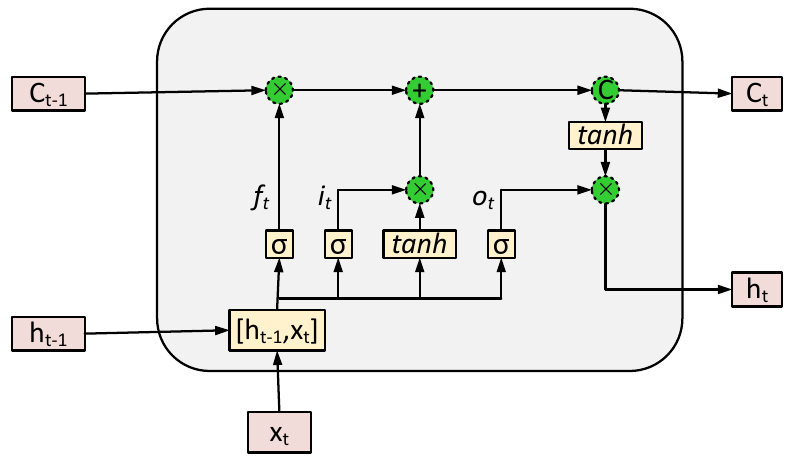
Figure 4. Architecture of the LSTM